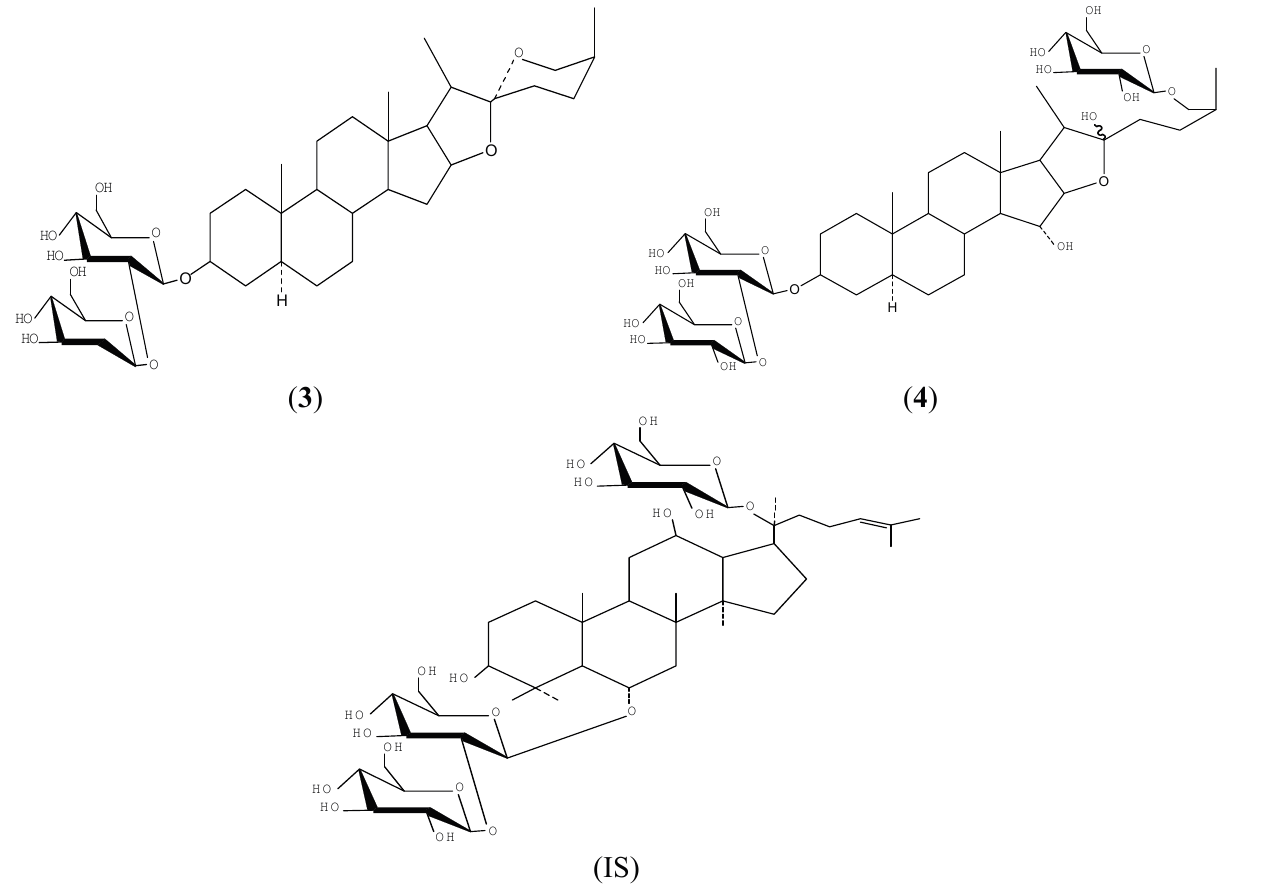
Figure 1. Chemical structures of timosaponinBII ( 1 ), anemarsaponin BIII ( 2 ), timosaponin AIII ( 3 ), timosaponin E1 ( 4 ) and ginsenoside Re